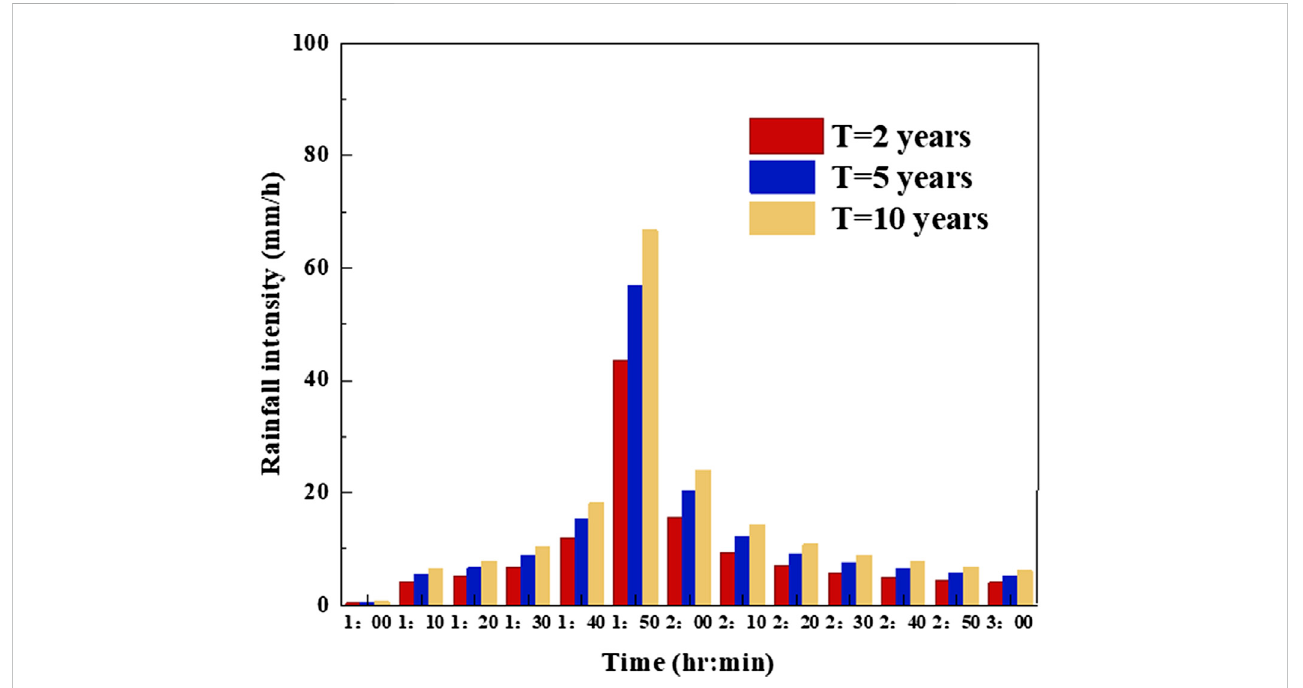
FIGURE 3 Rainfall distribution of Chicago rainfall patterns during three return periods.